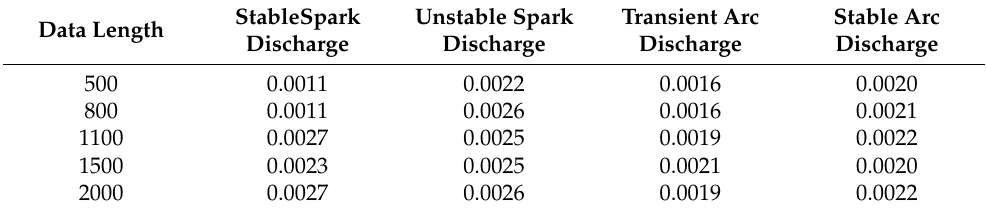
Table 2. Largest Lyapunov exponent of autonomous EDM process.